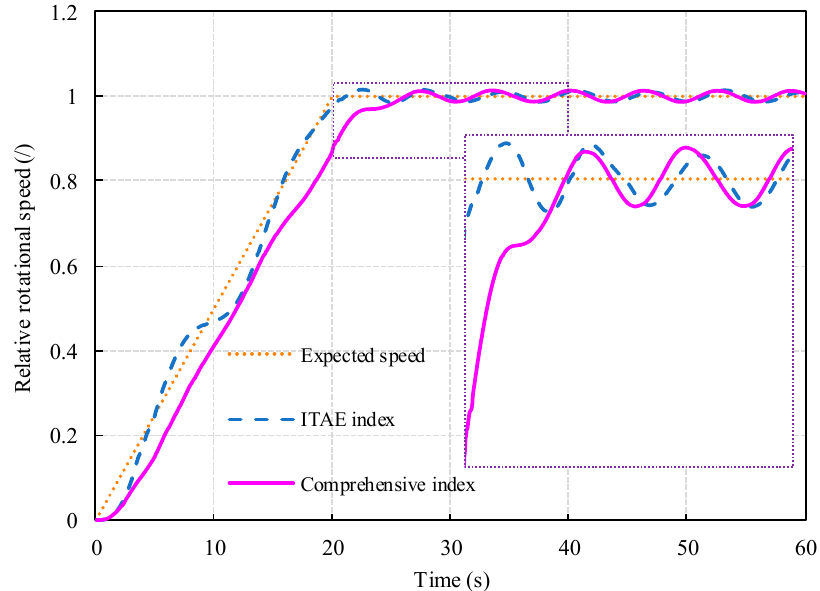
Figure 11. Optimization contrast curve of start-up speed characteristics.